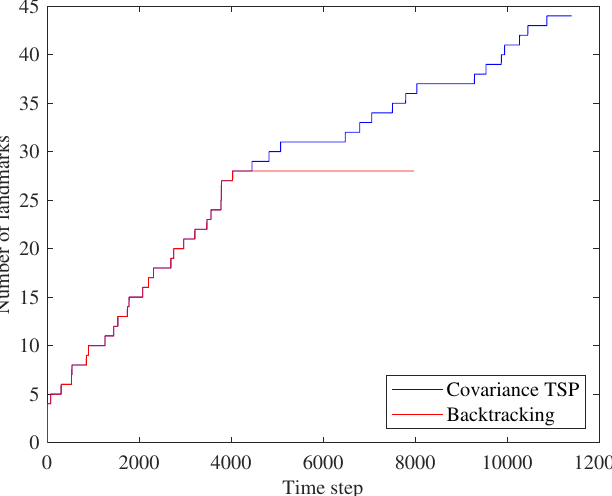
Figure 11. The number of registered